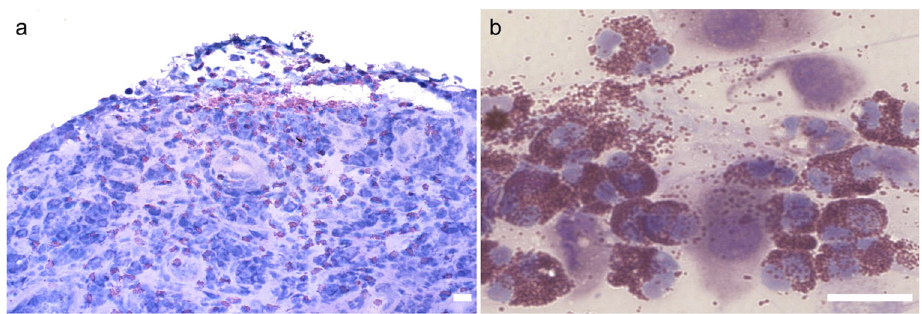
Figure 2. Eosinophils in giant papillae and tear fluids in patients with vernal keratoconjunctivitis (VKC). Accumulation of eosinophils (stained in red with Hansel staining) are apparent under a conjunctival epithelial erosion in giant papillae ( a ). Numerous degranulated eosinophils with detached epithelial cells were observed in the ocular discharge ( b ). Scale bars: 20 μ m. Reprinted with permission from [3]. Copyright 2022 Japanese Society of